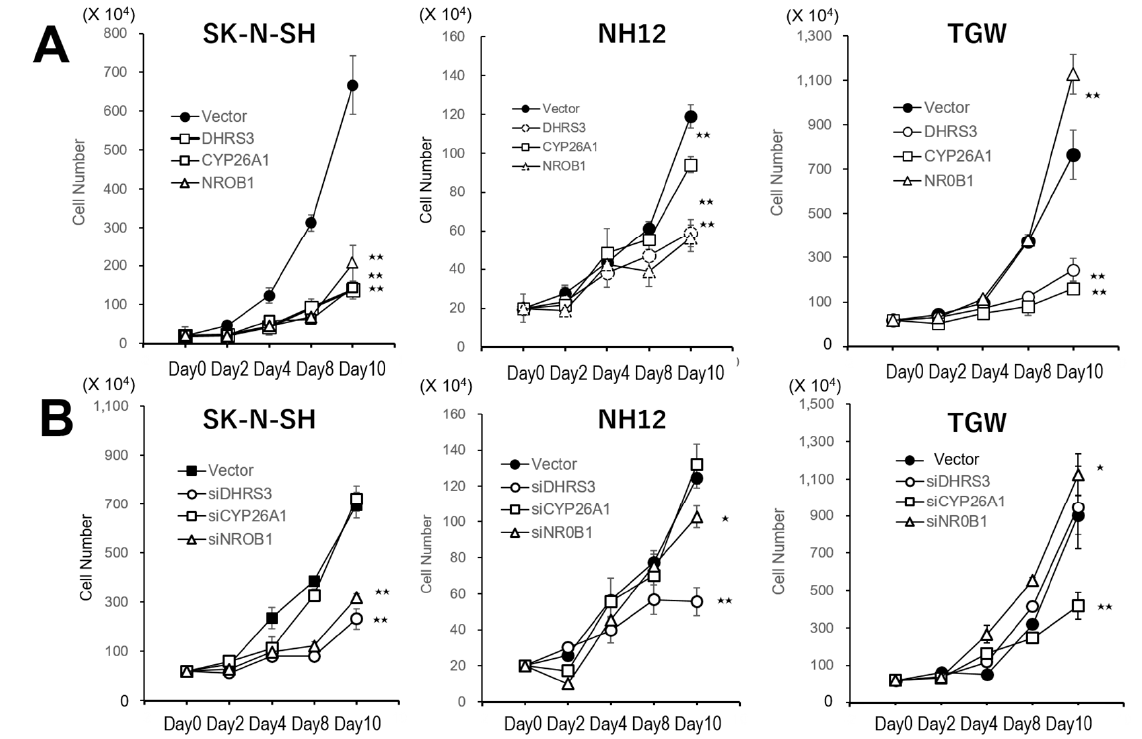
Figure 2. Cell-cycle analysis of cells by gene transfection or siRNA transduction. ( A ) Growth curves of neuroblastoma cells transfected with one of these genes selected by the favorable tumors. Overexpression of these factors reduced the growth rates. ( B ) Growth rates of siRNA transduction for each gene in these cell lines. The growth rates were not affected by siRNA transduction, but some siRNA transduction reduced the growth rates. Data points represent means ± SDs of triplicate wells. The growth rates of transfected cells were reduced, except for DHRS-transfected TGW cells. Native cell lines were confluent at 4–5 days in this culture condition. **: p < 0.01, *: p <